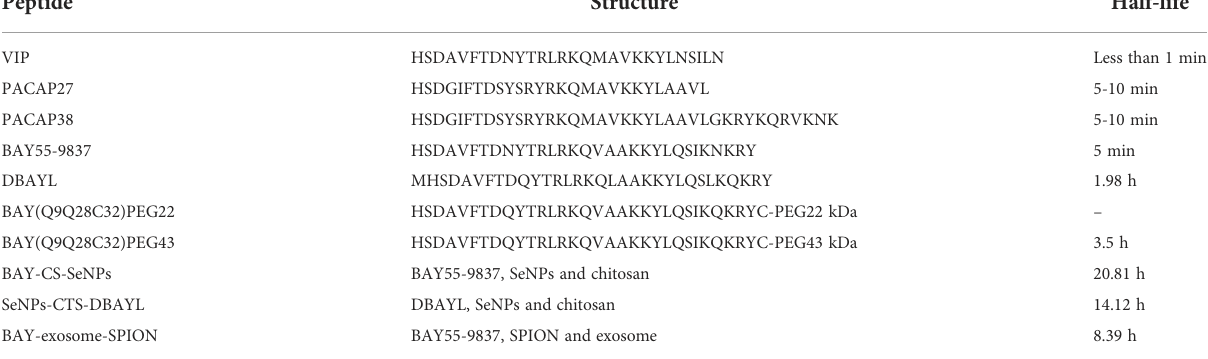
TABLE 1 Structure and half-life of VIP and VPAC2-selective agonists.